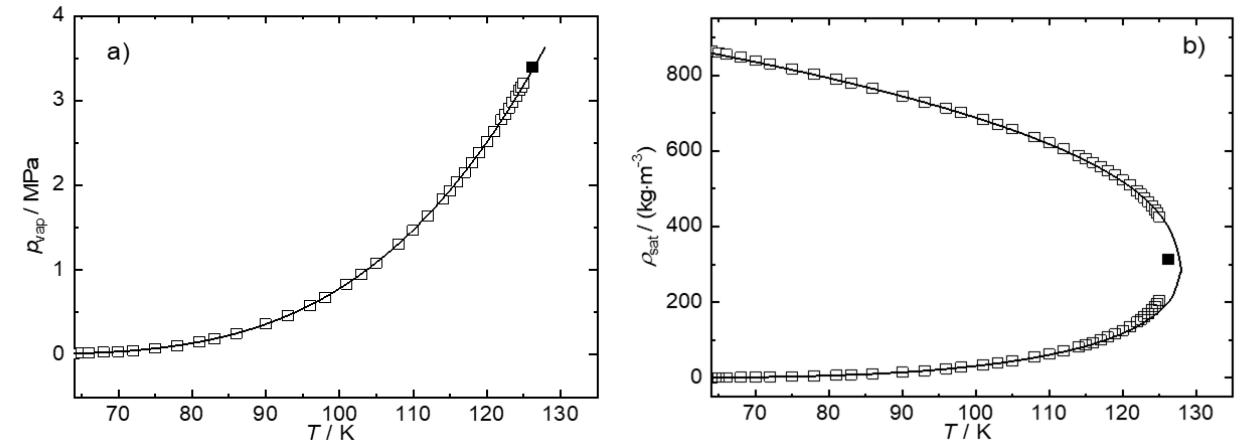
Figure 8. ( a ) Saturated densities and ( b ) vapour pressure for pure nitrogen. The empty symbols denote the experimental data [75], and the continuous line denotes the SAFT- γ Mie approach description with the parameters listed in Table 11. The filled-in black symbols represent the experimental critical point [61].